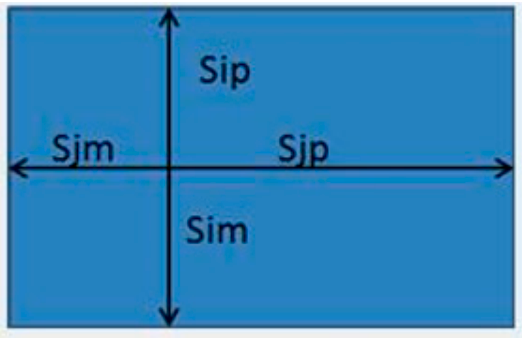
Figure 4. Sim, Sip, Sjm, and Sjp directions within a